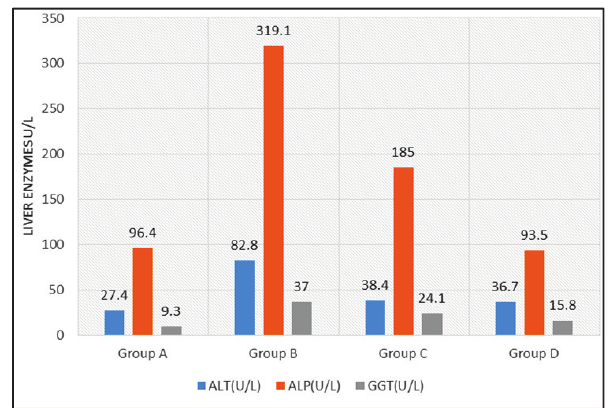
Fig-1: Mean values of ALT, ALP and GGT of all groups after six weeks of study.